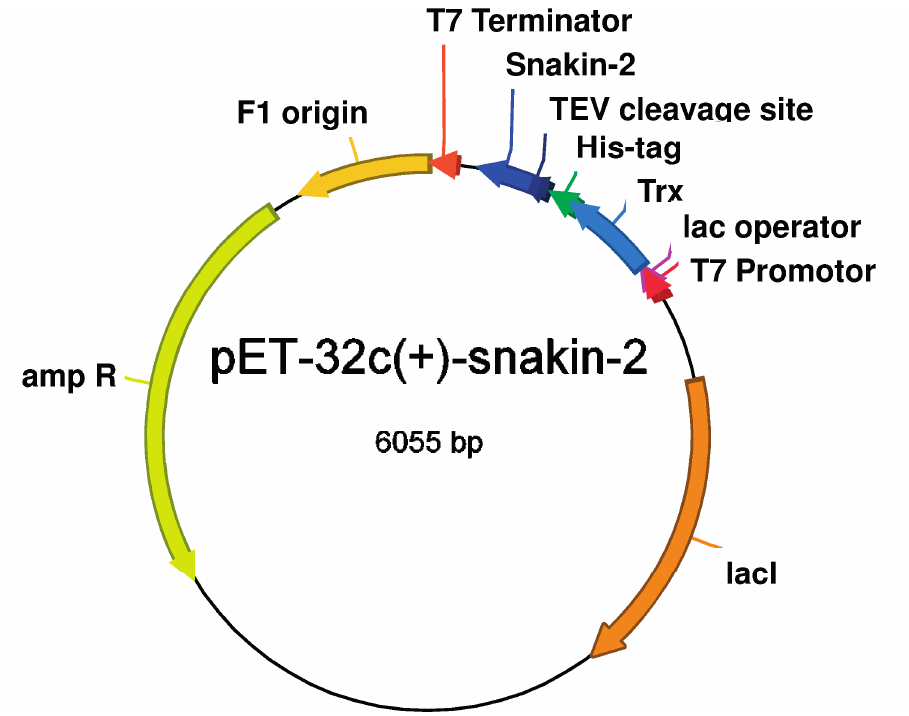
Figure 1. Schematic representation of the pET-32c(+)-SN2 expression